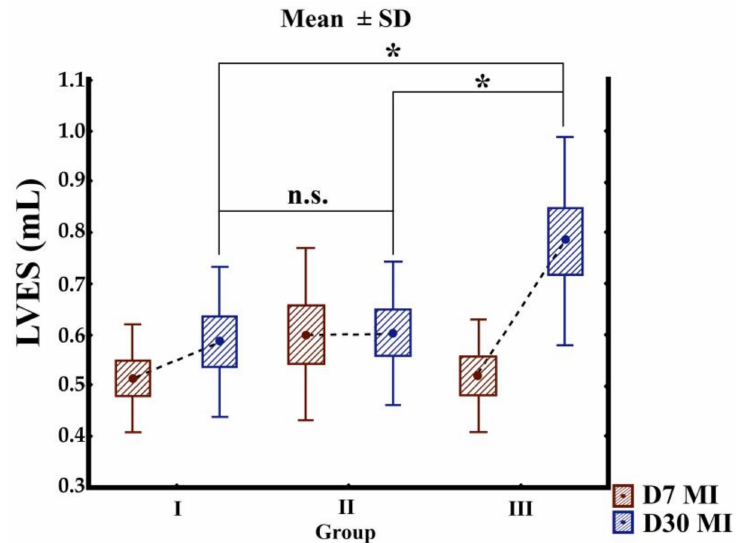
Figure 6. Graphs show echocardiographic measurements of left ventricular end-systolic (LVES). Mean values were calculated for each group seven days (D7) after and 30 (D30) days after MI. Group I: MI without treatment as a control group; group II: implantation of the BC matrix on the left ventricular surface; and group III: Implantation of the BC matrix seeded with cocultured cells on left ventricular surface. ns: not significant. Asterisk: significant.